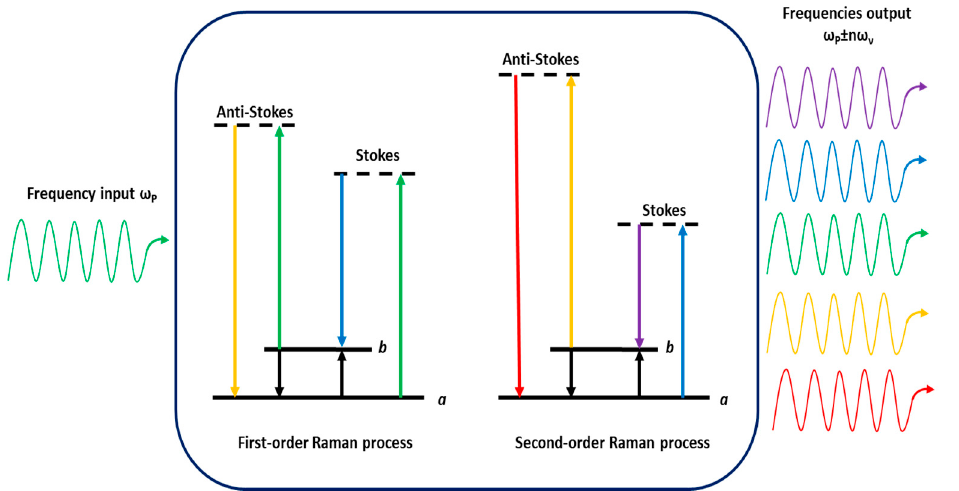
Figure 2. Cascaded Raman scattering principle. An input frequency ω P (green) can cause the spontaneous emission of frequencies ω P ± ω ν , [Stokes (blue) and anti-Stokes (orange)]. This initial spontaneous event provides the seed photons necessary for subsequent first-order SRS ( left ). The first-order Stokes and anti-Stokes photons then can cause second-order Raman scattering ( right ) to produce new frequencies ω P ± 2 ω ν (red and violet) and so on through propagation, resulting in a broadband ladder of frequencies ω P ± n ω ν